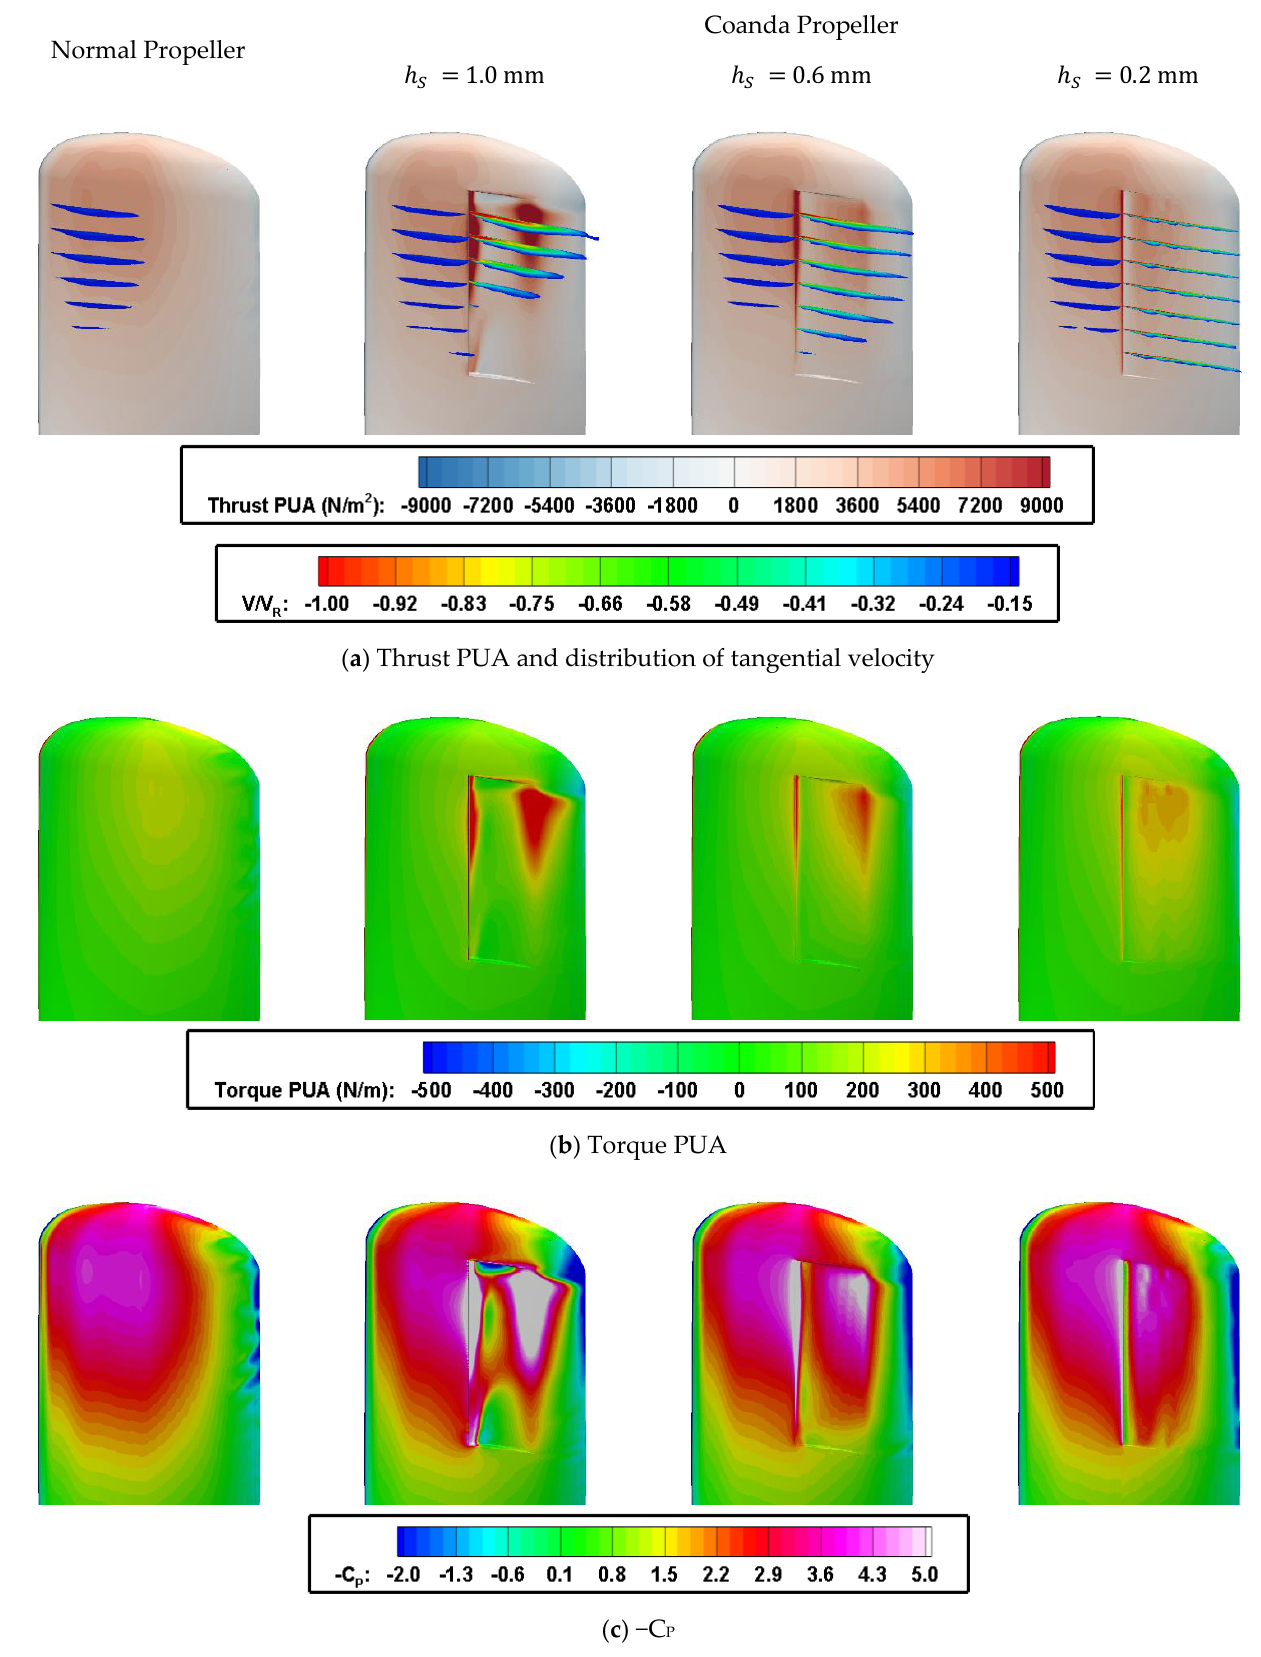
Figure 22. Comparison of changes in hydrodynamic force on the surface of a normal propeller and Coanda propellers (NACA66 (MOD, t/c = 0.12)).